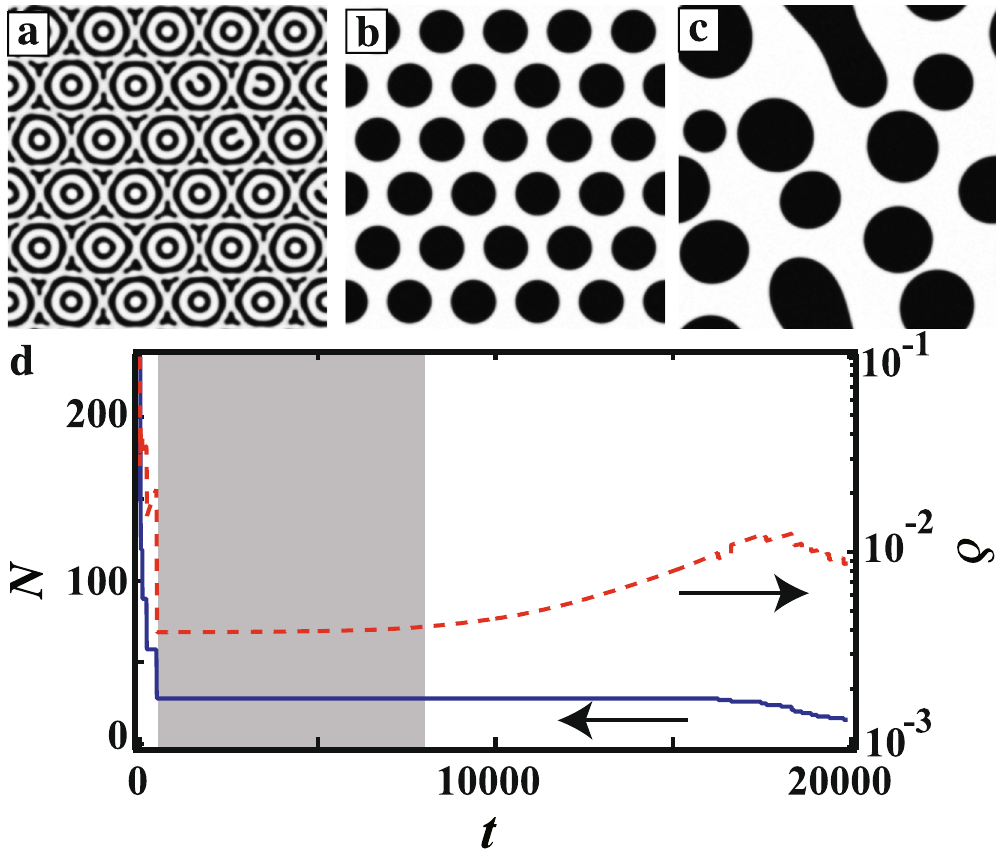
Figure 5. Time evolution of a concentric circle pattern with multiple propagated triggers when Δ d = 80, = 0.5. ( a ) By t = 80, a concentric circle pattern has formed at each core. ( b ) At t = 5000, a φ = 0.1, and v tri hexagonal pattern is observed after coarsening of the concentric circles. ( c ) Finally, at t = 20000, the hexagonal pattern collapses due to thermal noise. The arrangement and size distribution of the droplets becomes random. ( d ) Time evolution of the number of domains N (solid line) and the size distribution of the domain δ (dotted line). N and δ are large at the beginning of the phase separation since concentric circles are formed. N and δ decrease due to coarsening and a regular hexagonal pattern is formed. δ remains constant from t = 500 to 8000 (shaded region), showing that the regular hexagonal pattern is stable. After t = 8000, the droplet sizes have a narrow distribution due to thermal noise, and δ gradually increases. By t = 15000, the RHD pattern has collapsed due to